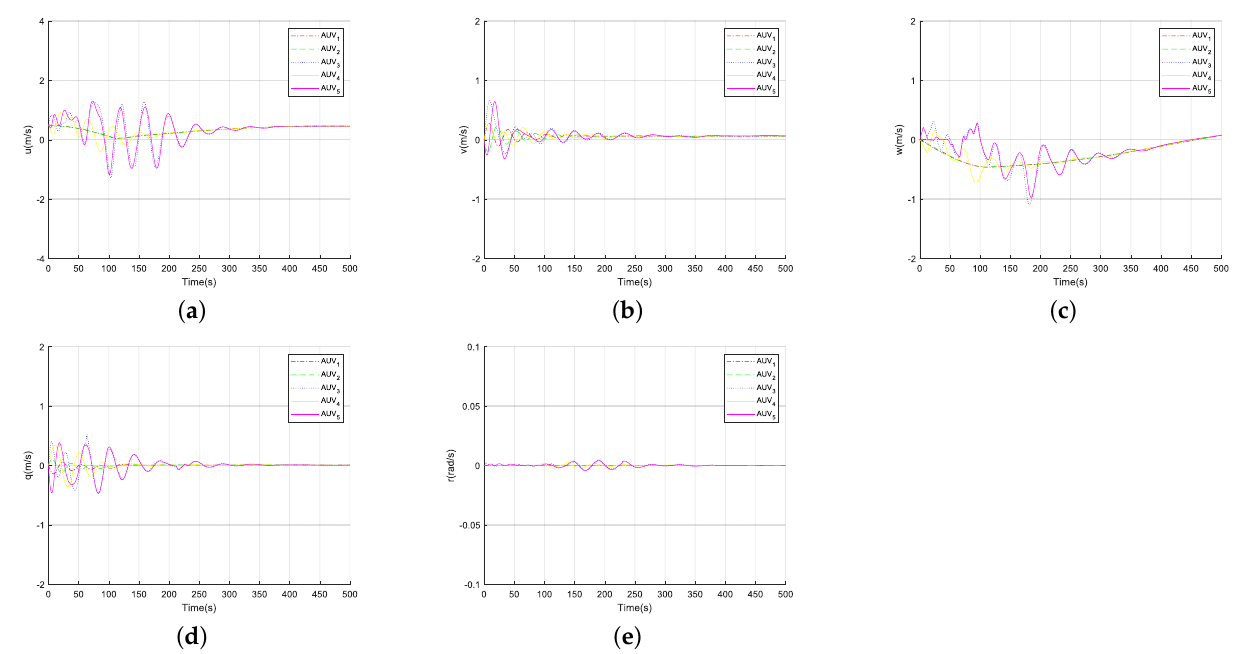
Figure 10. The other states of the multi − AUV formation: ( a ) the u state of multi − AUV, ( b ) the v state of multi − AUV, ( c ) the w state of multi − AUV, ( d ) the q state of multi − AUV, ( e ) the r state of multi −